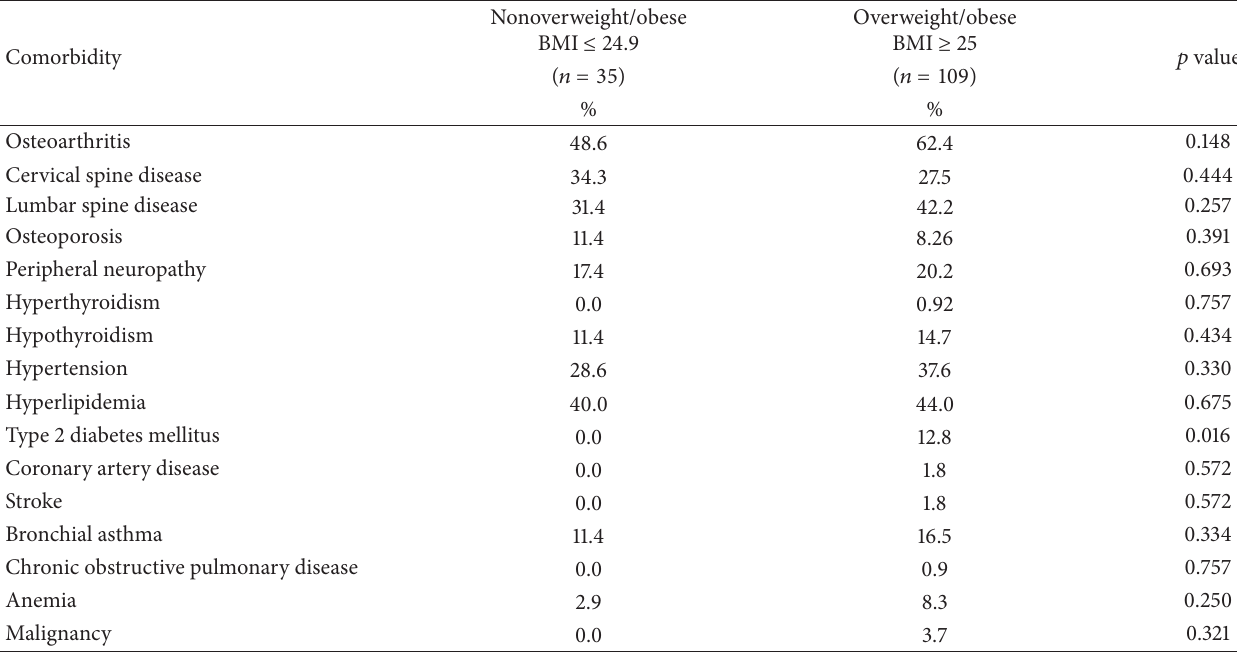
Table 3: Comorbidities in nonoverweight/obese and overweight/obese patients with fibromyalgia syndrome.